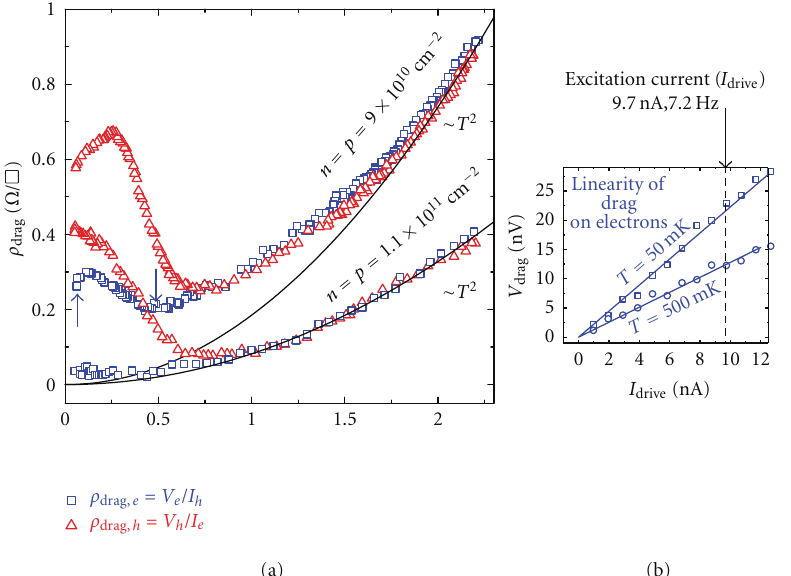
Figure 11: (a) Electron and hole drag resistivities versus temperature for n = p = 9 and 11 × 10 10 cm − 2 versus temperature, down to 50mK. T 2 coe ffi cients are 0.08 and 0 . 19 Ω / (cid:2) K − 2 , respectively. (b) I - V trace for drag on electron layer for n = p = 9 × 10 10 cm − 2 , indicated by arrows (a). Electron and hole layer mobilities at T = 1 . 5K, μ e = 1 . 5 × 10 6 cm 2 V − 1 s − 1 and μ h = 1 . 1 × 10 5 cm 2 V − 1 s − 1 . (Device: B138/C4-1-10nm